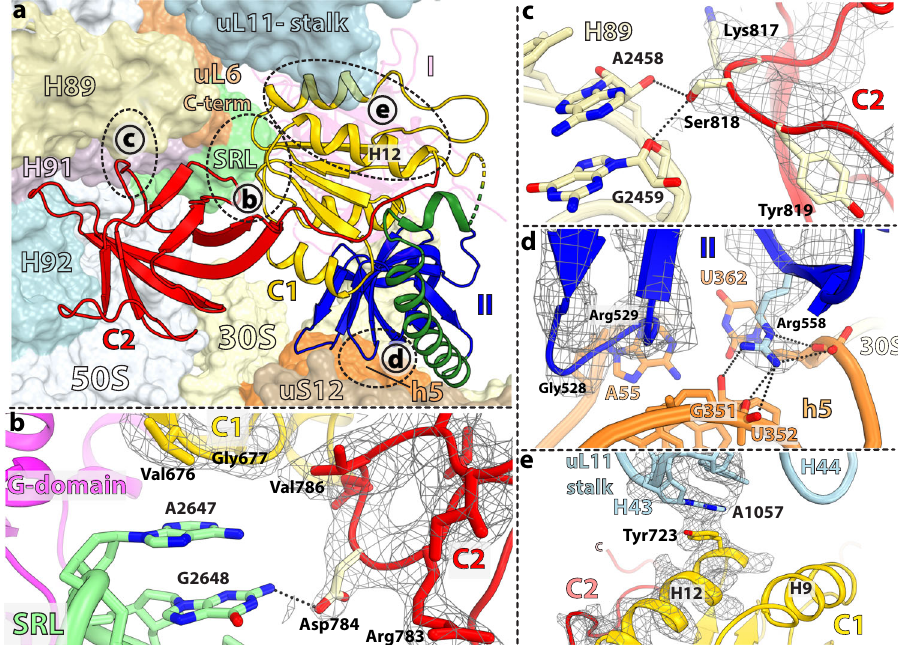
Fig. 5 Interactions between compact IF2 and the ribosome. a Overview of compact IF2-GDP bound to the 70 S ribosome. Domain C1 (yellow) locates under the uL11-stalk (light blue) while domain C2 (red) is disposed along the aminoacyl-tRNA accommodation corridor in the vicinity of 23 S rRNA helices H89 (pale yellow), H91 (light pink), H92 (light blue), and the SRL (pale green), and the C-terminal of r-protein uL6 (light orange). Domain II (blue) interacts with helix h5 of 16 S rRNA (orange). b – e Magni fi ed views of the insets shown in a . b Domain C1 is sandwiched between the G- and C2-domains, together surrounding the SRL of 23 S rRNA (pale green). Residue Asp 784 in domain C2 (red) interacts with G2648 ( E. coli G2661) in the SRL. Residues Val 676 and Gly 677 in domain C1 (yellow) form a fl at surface that stacks with the apical nucleotide A2647 (A2660) in the SRL. EM density shown as gray mesh. c Residue Ser 818 in domain C2 (red) is within hydrogen bonding distance to nucleotides A2458 (A2471) and G2459 (G2472) in 23 S rRNA helix H89 (pale yellow). d The main chain of residues Gly 528 and Arg 529 , and the side chain of Arg 558 in domain II (blue) stack with base pair A55-U362 (A55-U368) in helix h5 of 16 S rRNA (orange). e The conserved Tyr 723 in helix H12 of domain C1 (yellow) stacks with nucleotide A1057 (A1067) in 23 S rRNA helix H43 of the